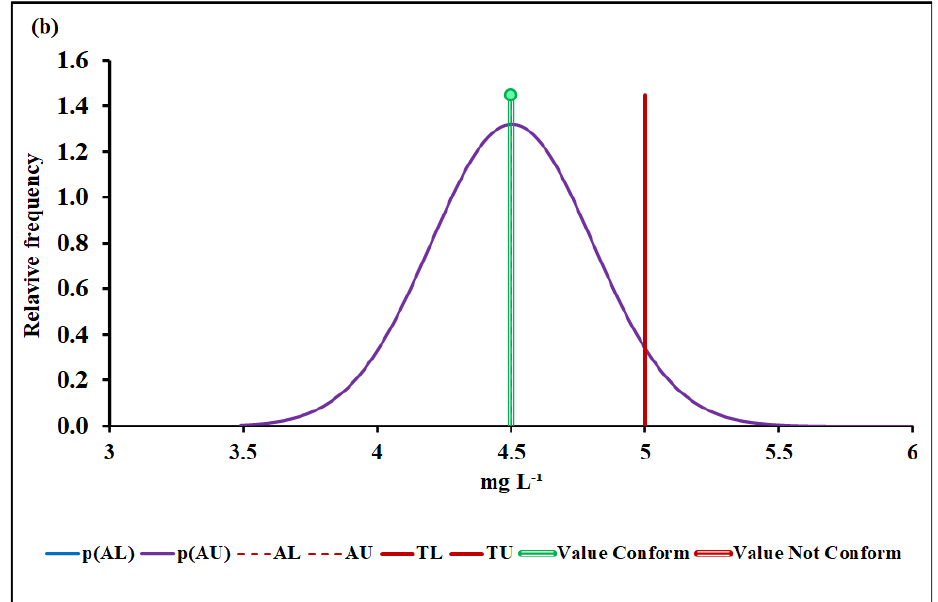
Figure 4. BOD conformity assessment based on ( a ) MADe approach and ( b ) nIQR approach. p(AL) − probability density at the lower acceptance limit; p(AU) − probability density at the upper acceptance limit; AL − lower acceptance limit; AU − upper acceptance limit; TL − lower tolerance limit; TU − upper tolerance limit.